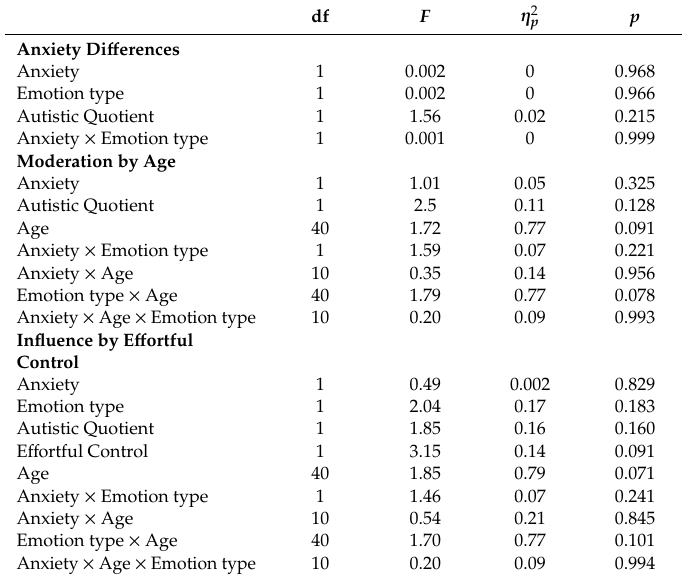
Table A1. Results of the mixed ANCOVAs for mean proportions of trials where the initial look was to the emotional face.